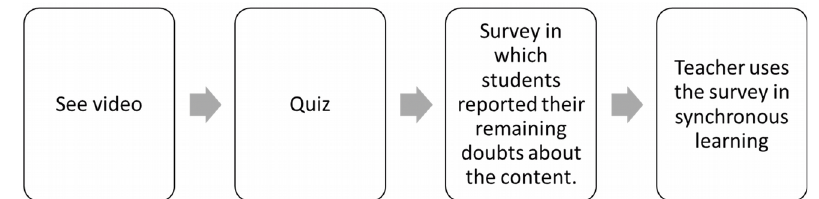
Figure 2. The sequence of activities in the development of the student’s